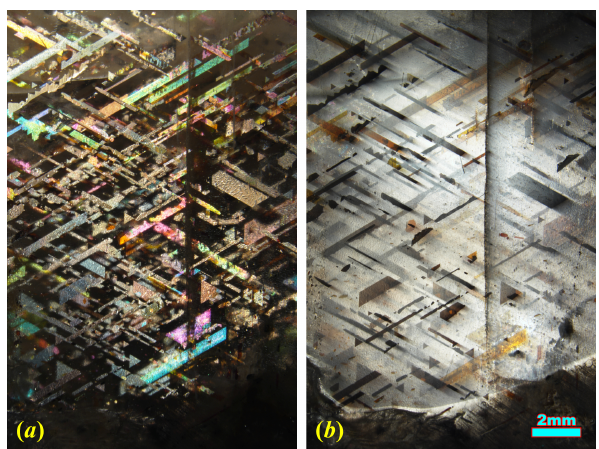
Figure 1. The same RLS crystal showing aventurescence (a) and adularescence (b) under reflective light from different angles. Aven- turescence is reflection of light from the iron oxide inclusions (dark matrix, bright inclusions), and adularescence is reflection and inter- ference of light from the feldspar (bright matrix, dark